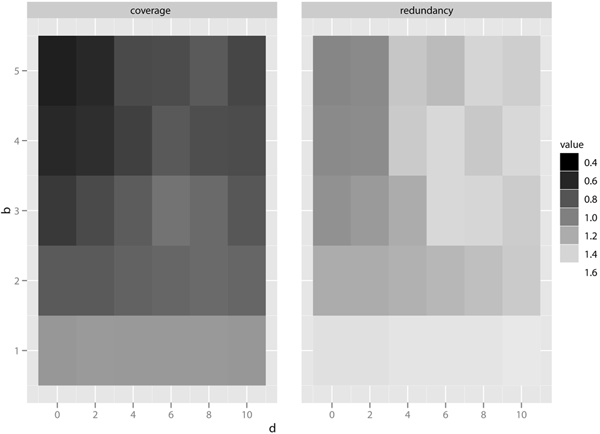
Effect of b and d.